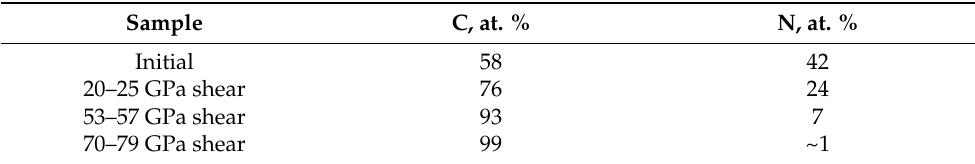
Table 1. Concentrations of carbon and nitrogen in the g -C 3 N 4 specimen after shear deformation. Sample C, at. %